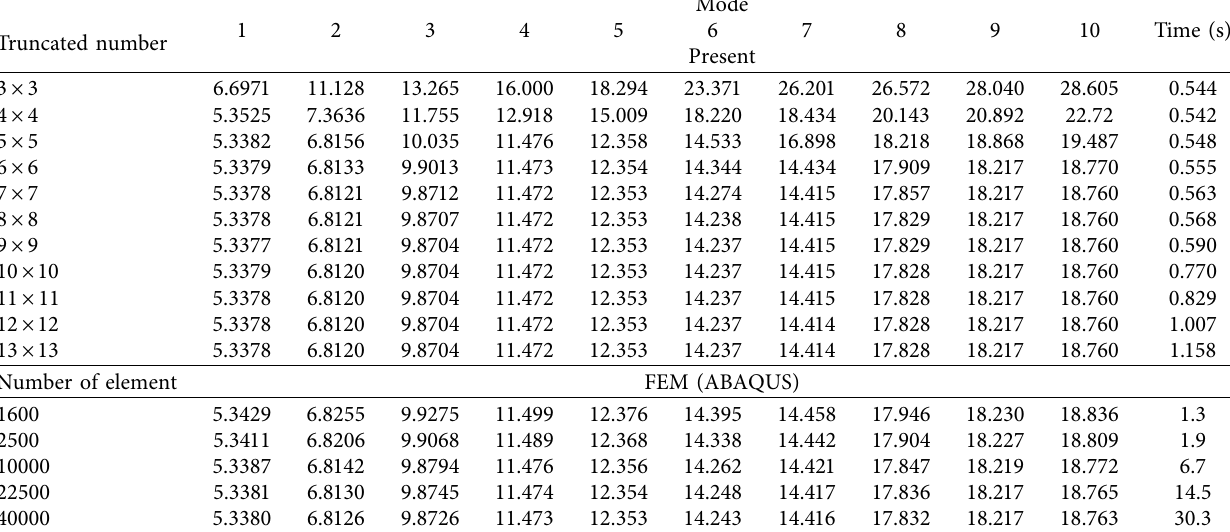
Table 1: Convergence of dimensionless frequencies of stepped FG-CNTRC plate.